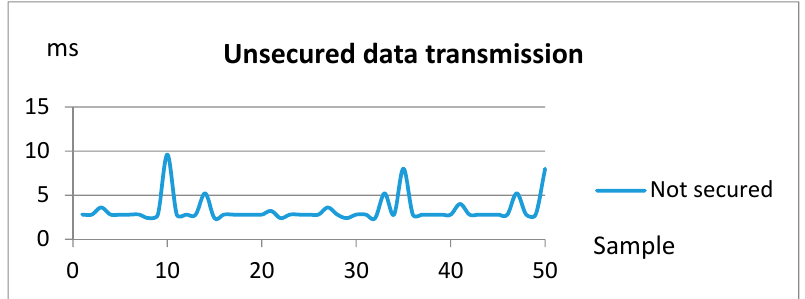
Figure 18. Performance measurements with unsecured data transmission. Figure 18 . Performance measurements with unsecured data transmission. Figure 18 . Performance measurements with unsecured data transmission.